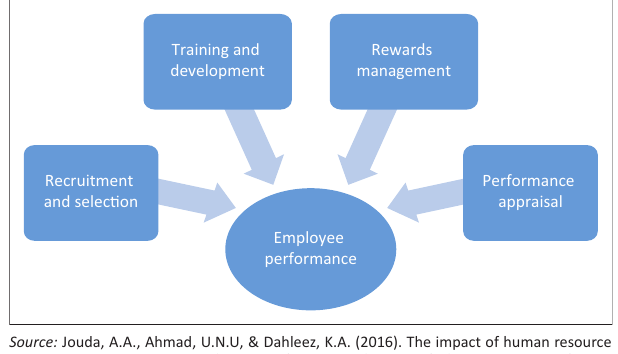
FIGURE 1: Human resource management practices that are positively related to employee